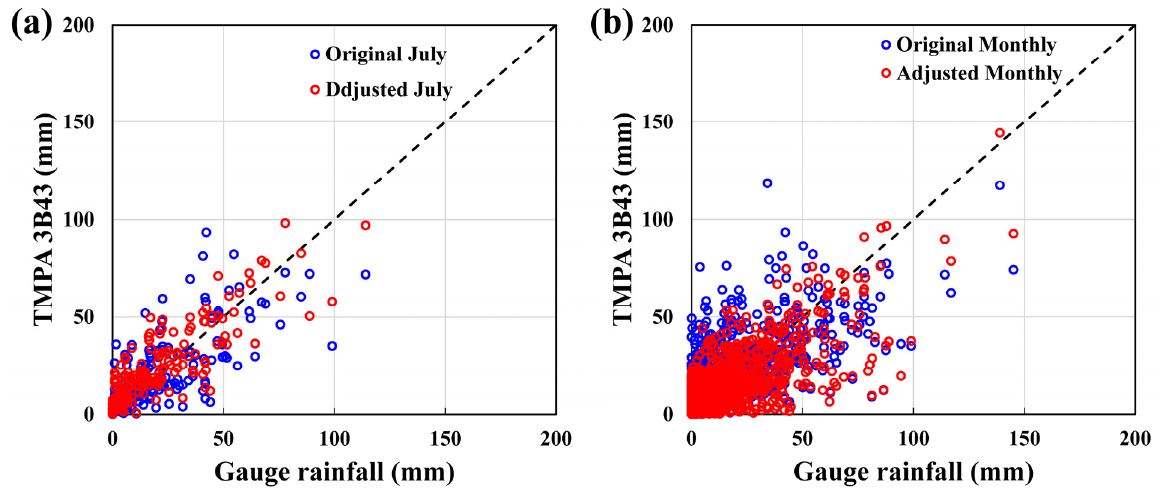
Figure 7. Comparison between 3B43 rainfall (original and corrected) and gauge rainfall on every July ( a ) and every month ( b ) in Kunlun during 2001–2012.